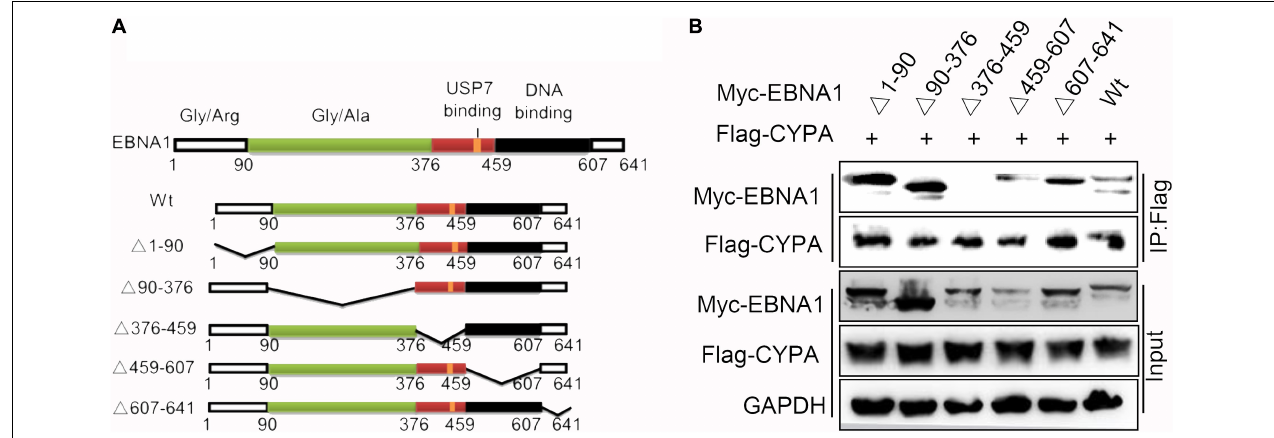
FIGURE 2 | Identification of the EBNA1 domain required for binding to CYPA. (A) Diagram of the EBNA1 deletion mutants. The start and end amino acid residues for each fragment are indicated according to a previous report (Young and Murray, 2003). (B) Validation of the interaction between each mutant EBNA1 and CYPA by the co-IP assay. PCAGGS-Myc-EBNA1, pCAGGS-Myc-EBNA1 mutants, and pCAGGS-Flag-CYPA were transfected into HEK293 cells. Myc-EBNA1 was immune-precipitated with anti-FLAG antibody. Flag-CYPA and Myc-EBNA1 were detected by